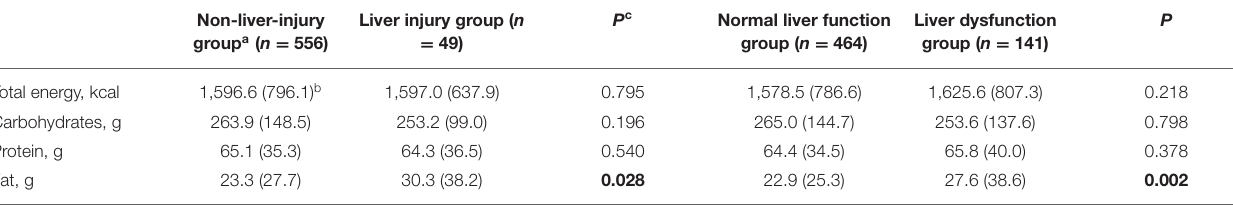
TABLE 2 | The estimated daily macronutrients intake for the